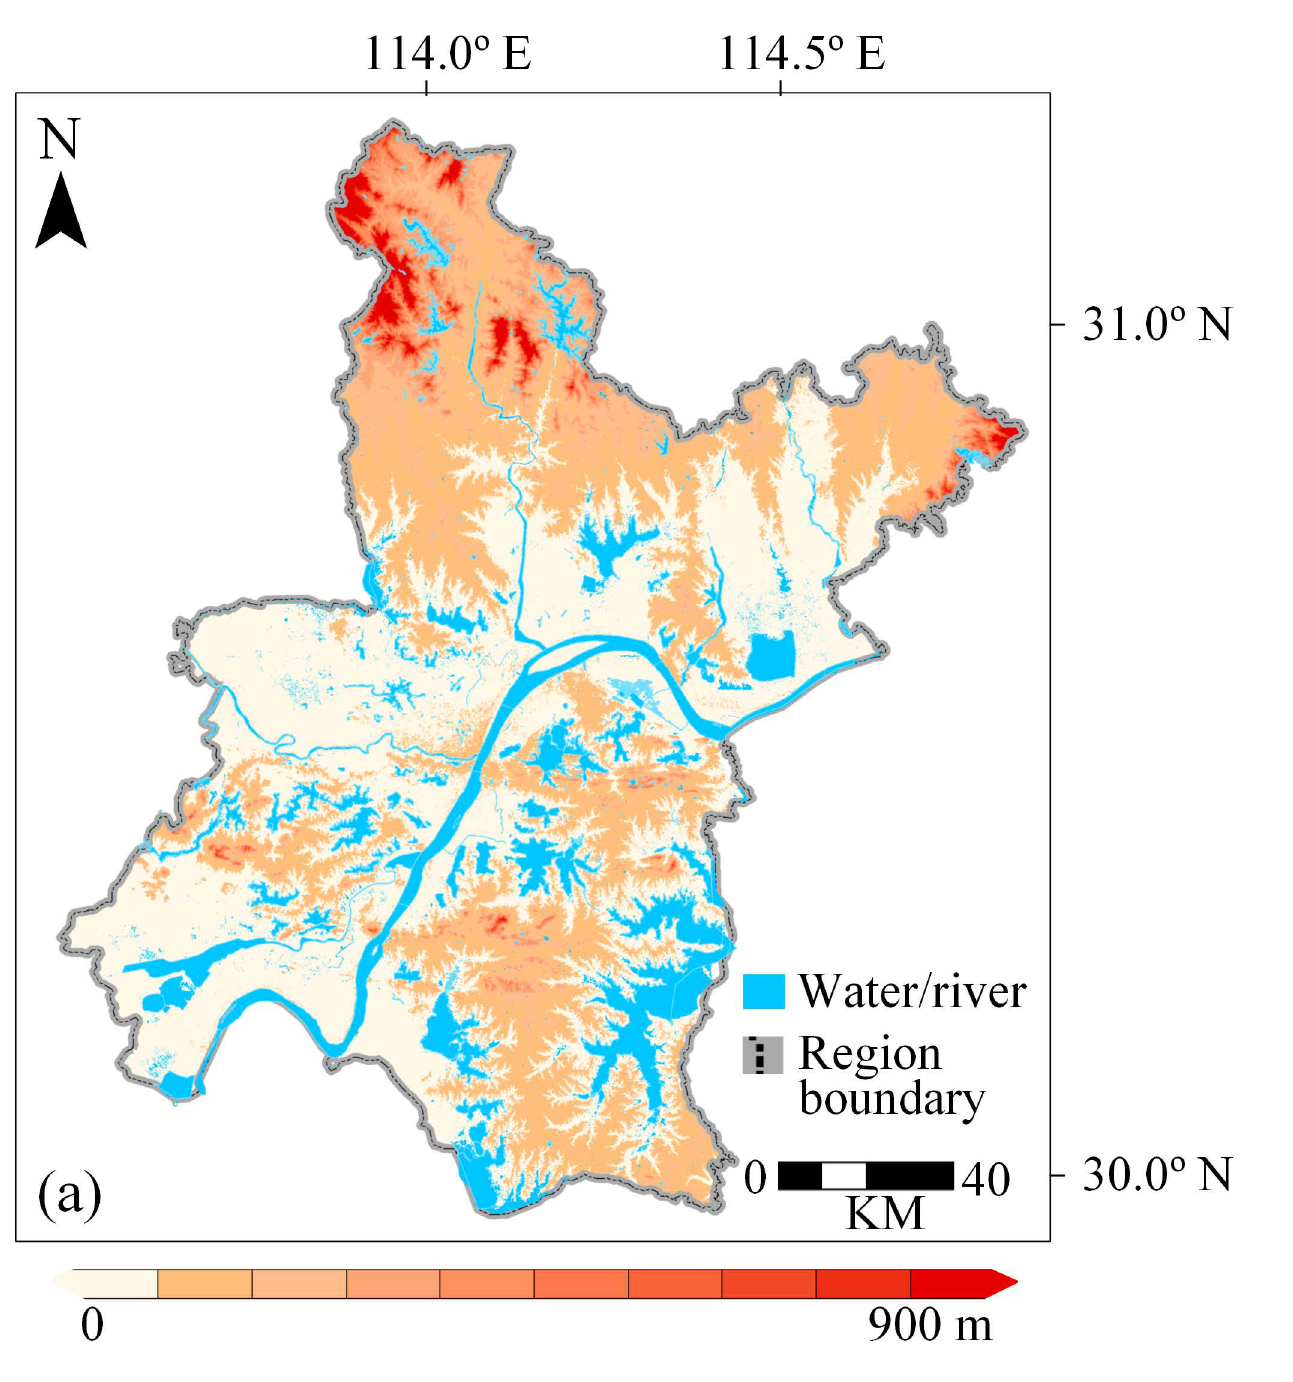
Figure 5. DEM ( a ) and the coe ffi cient for percentage of landscape (PLAND, ( b ) and aggregation index (AI, ( c )) from geographically weighted regression